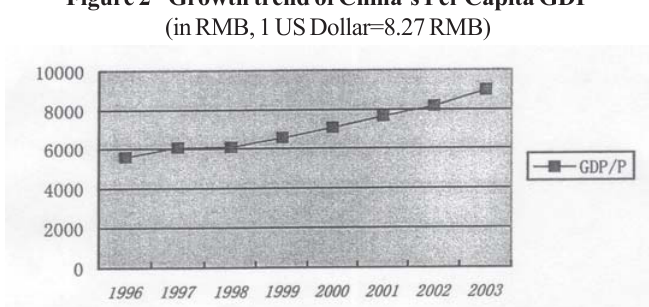
Source: China Statistical Year book, www.cei.gov.cn. Figure 2 Growth trend of China’s Per Capita GDP (in RMB, 1 US Dollar=8.27 RMB)